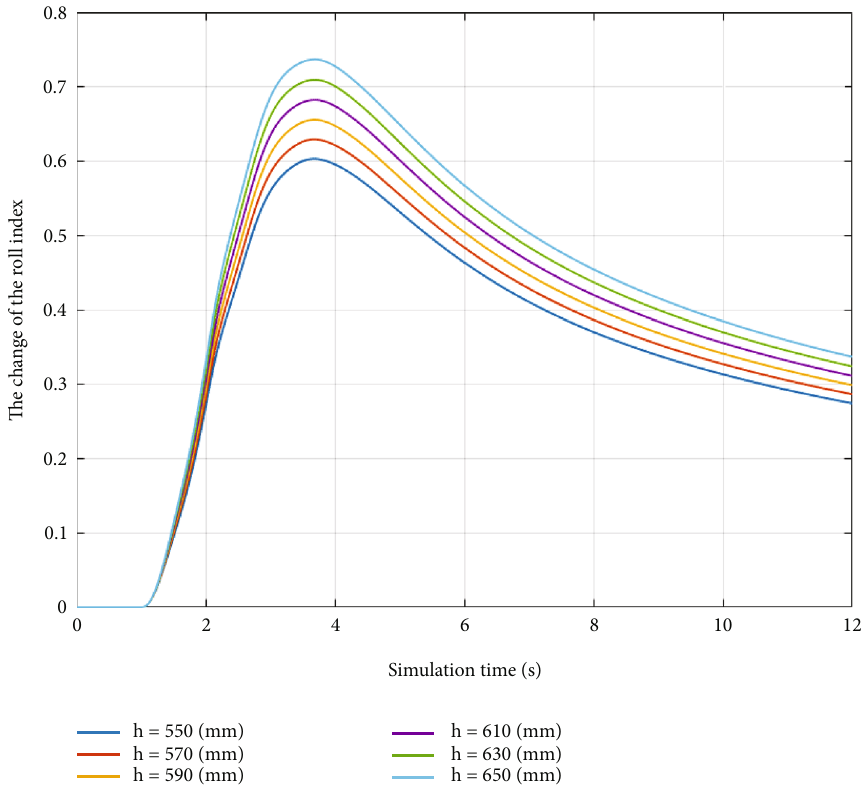
Figure 7: The change of the roll index (the fi rst case — distance change).